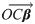
Statistical probability distributions for the angular difference between the Anton trajectory vectors OCβ→ and the reconstructed vectors in the Statistical Method, ScwrIPP and Remo.a) villin, b) ww-domain.